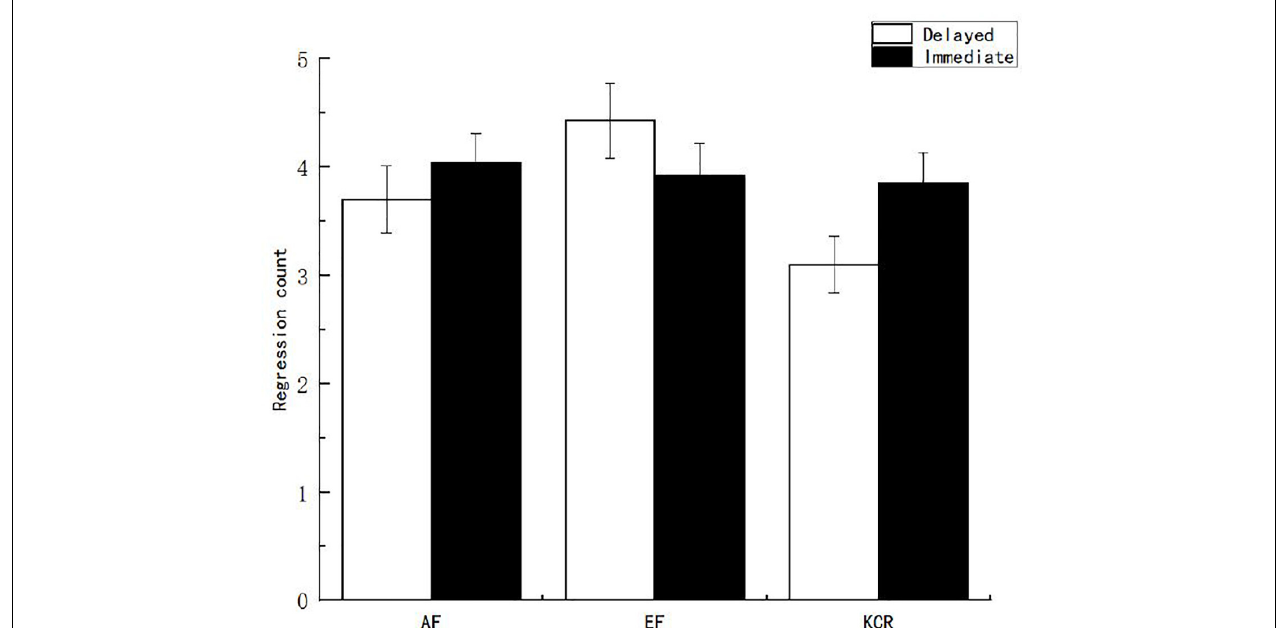
FIGURE 9 | Regression count of learners on the feedback interest area under different feedback